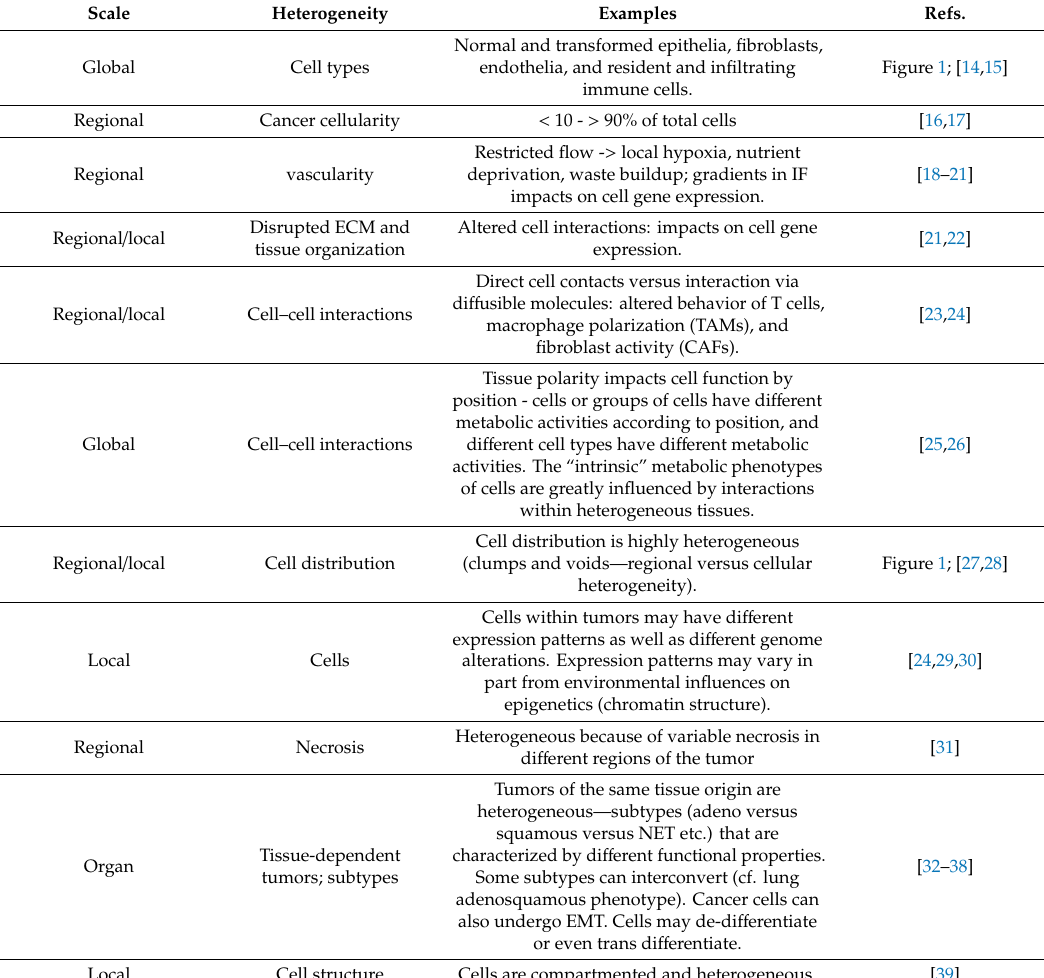
Table 1. Tumor tissue heterogeneity. Scale refers to the size of the unit, from individual cells (local) to groups of cells or tissue (regional) to global (organism). Examples